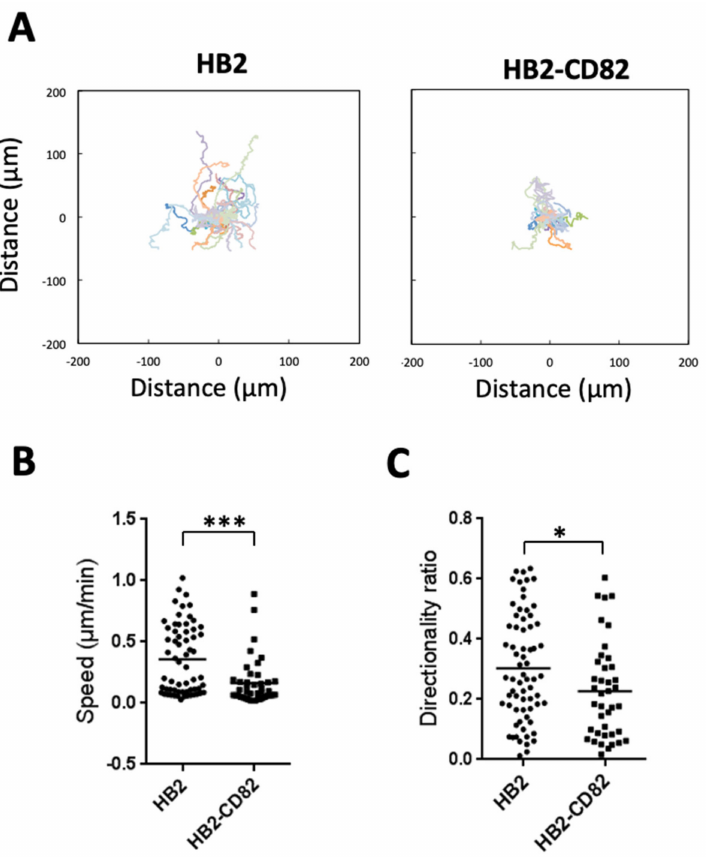
Figure 1. CD82 regulates EGF-induced single-cell persistent migration. ( A ) Trajectories of the 10 EGF- stimulated single HB2 or HB2-CD82 cells; ( B ) average speed of the cells; ( C ) directionality ratio of the cells determined as the shortest distance between the starting and arrival points divided by the real distance traveled by the cells (n = 68 and 40 cells, respectively, for HB2 and HB2-CD82, obtained from 10 independent experiments), * p < 0.05, *** p <